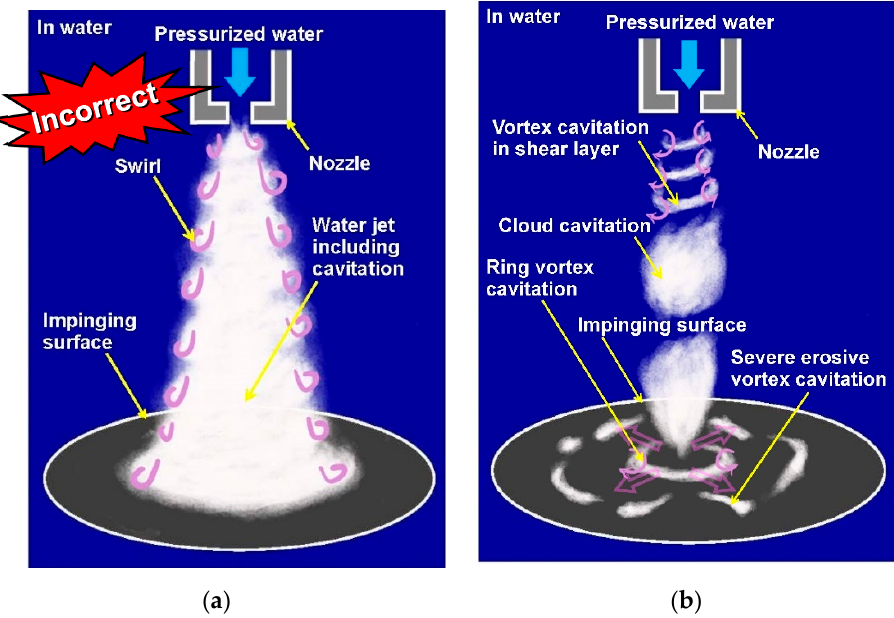
Figure 9. Schematic diagram of cavitating jet: ( a ) swirl; ( b ) vortex, cloud and ring cavitation.